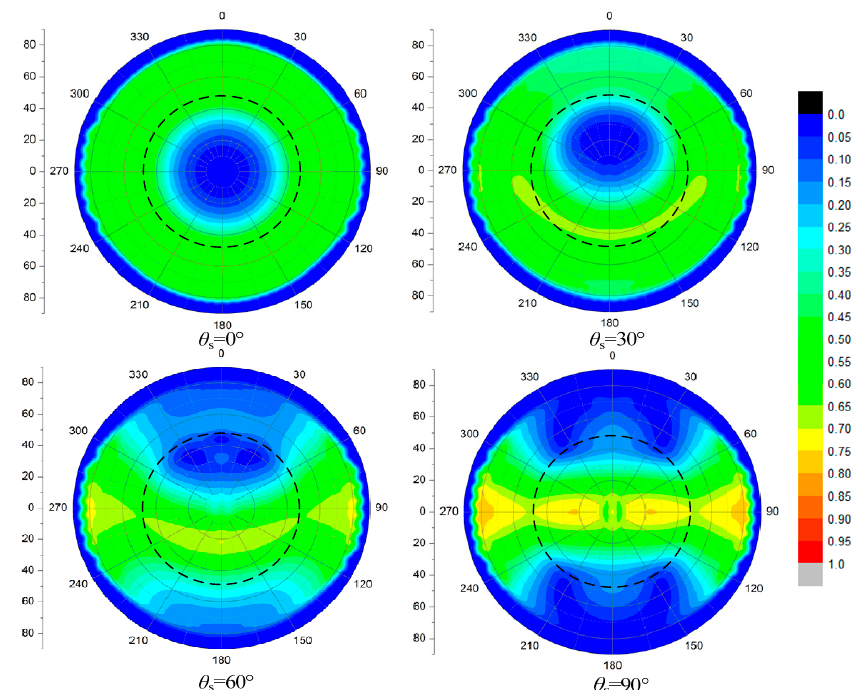
Figure 7. The DOP patterns of full incident light transmitted through a wavy water surface under different SZAs, where wind speed is 5 m/s, wind direction is 0°.